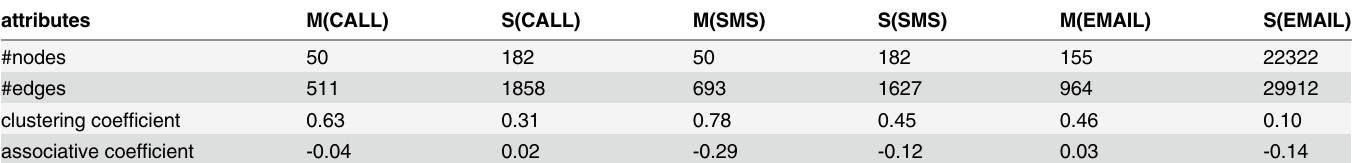
Table 3. Topology characteristics of sub-networks. M: Managers; S: Subordinates.